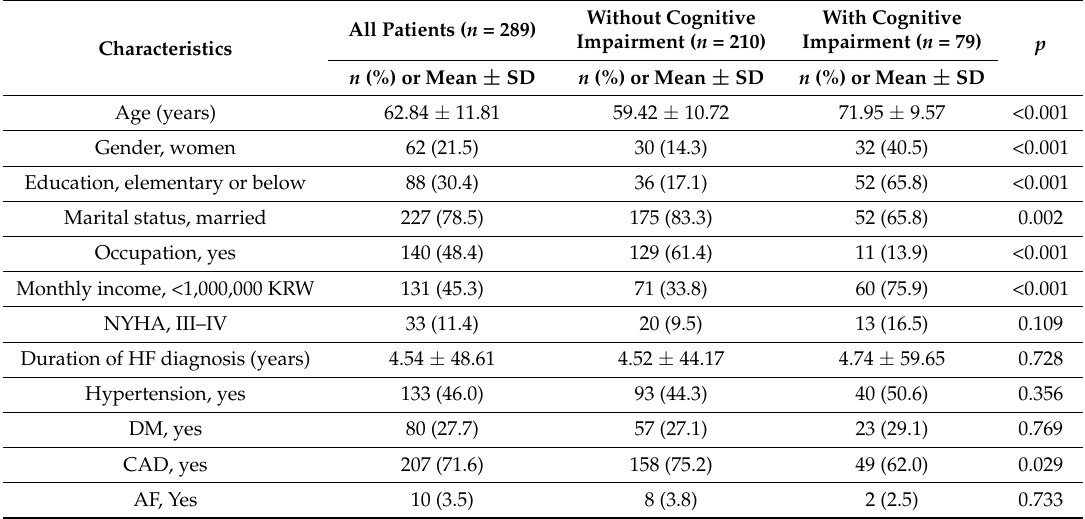
Table 1. Comparison of patients characteristics, depression, frailty, and cognitive function among heart failure patients with and without cognitive impairment ( n =